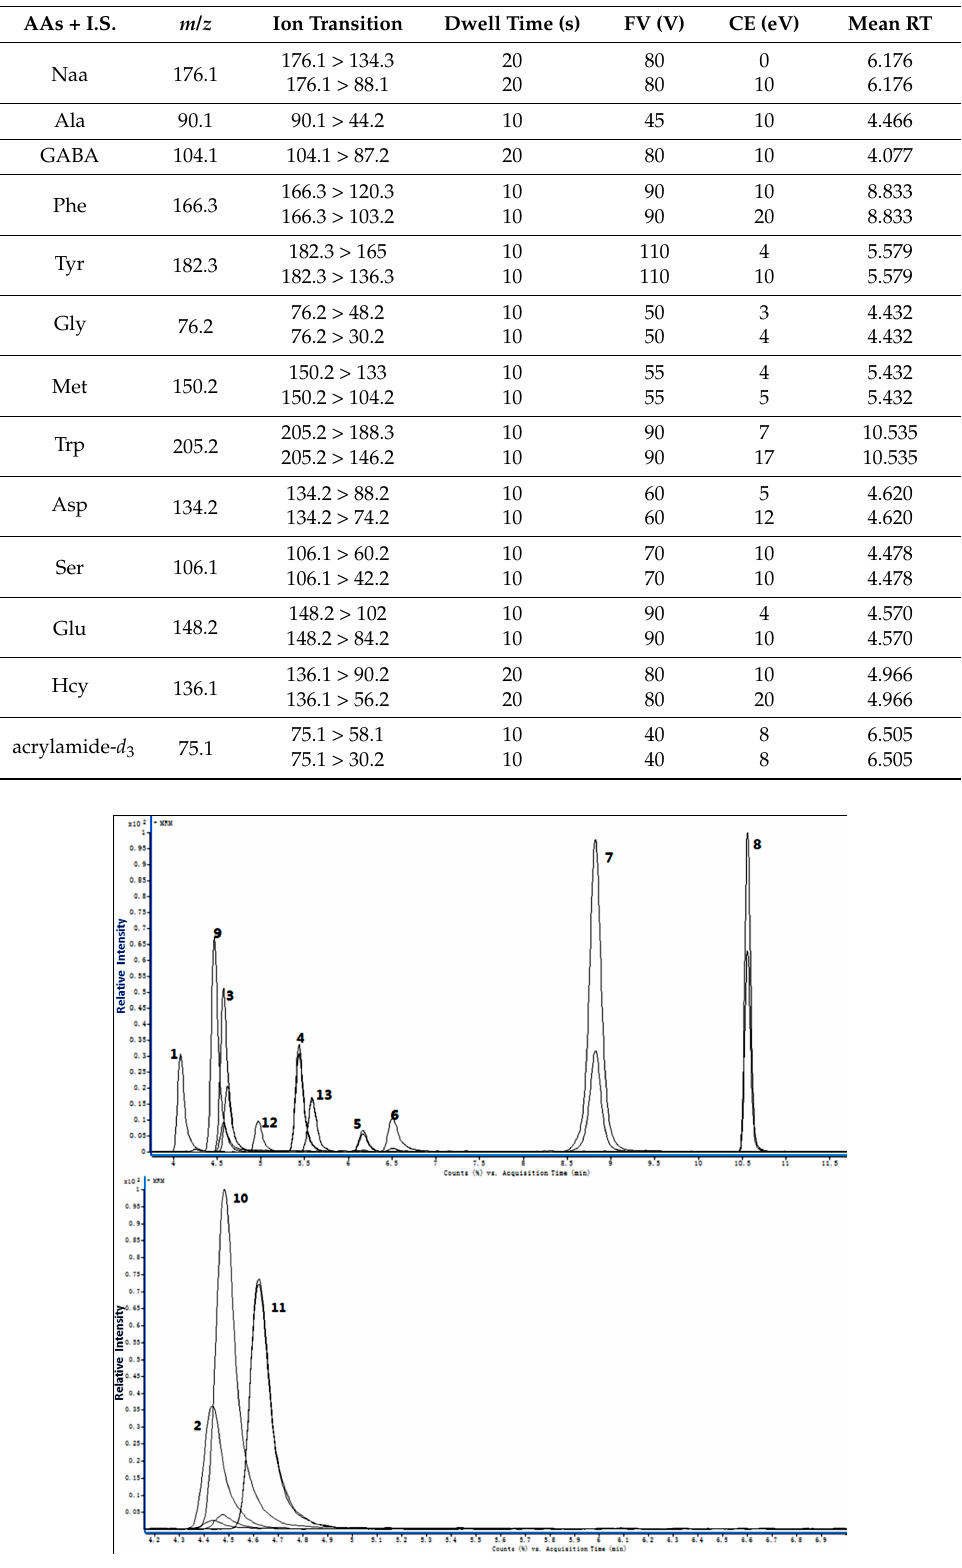
Table 1. Ion transitions for AAs and instrumental parameters for MS-MS detection in MRM mode. AAs + I.S.